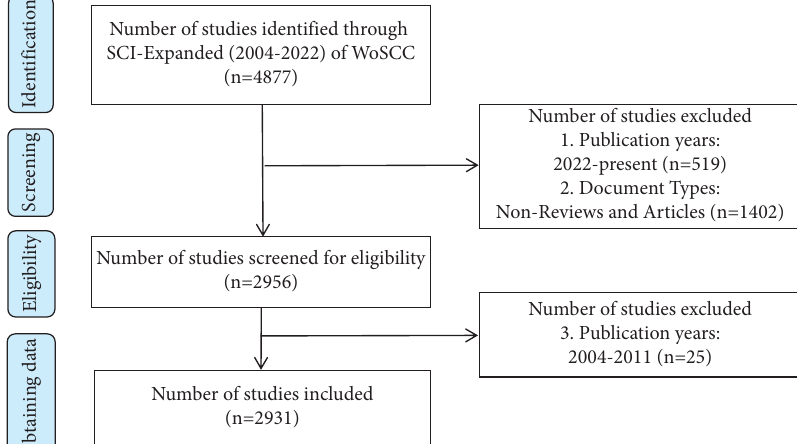
Figure 1: Diagram of paper search and screening process.